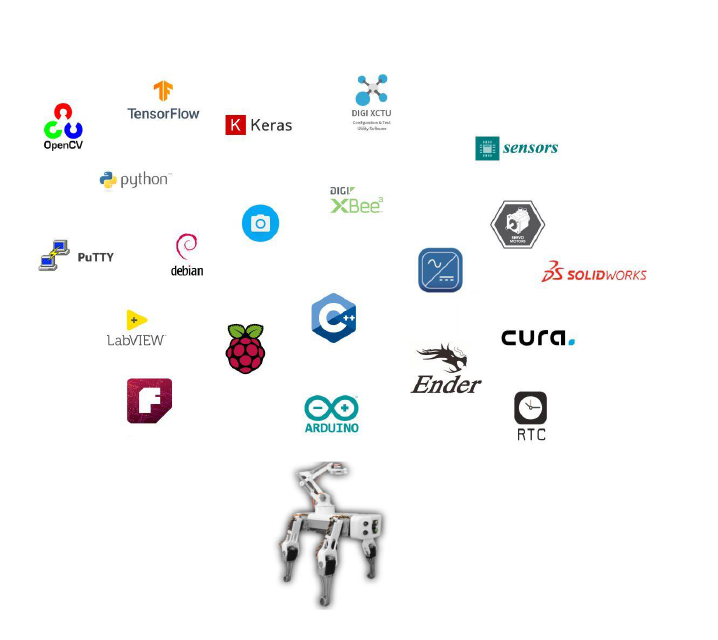
Figure 5. Technologies used in our system.